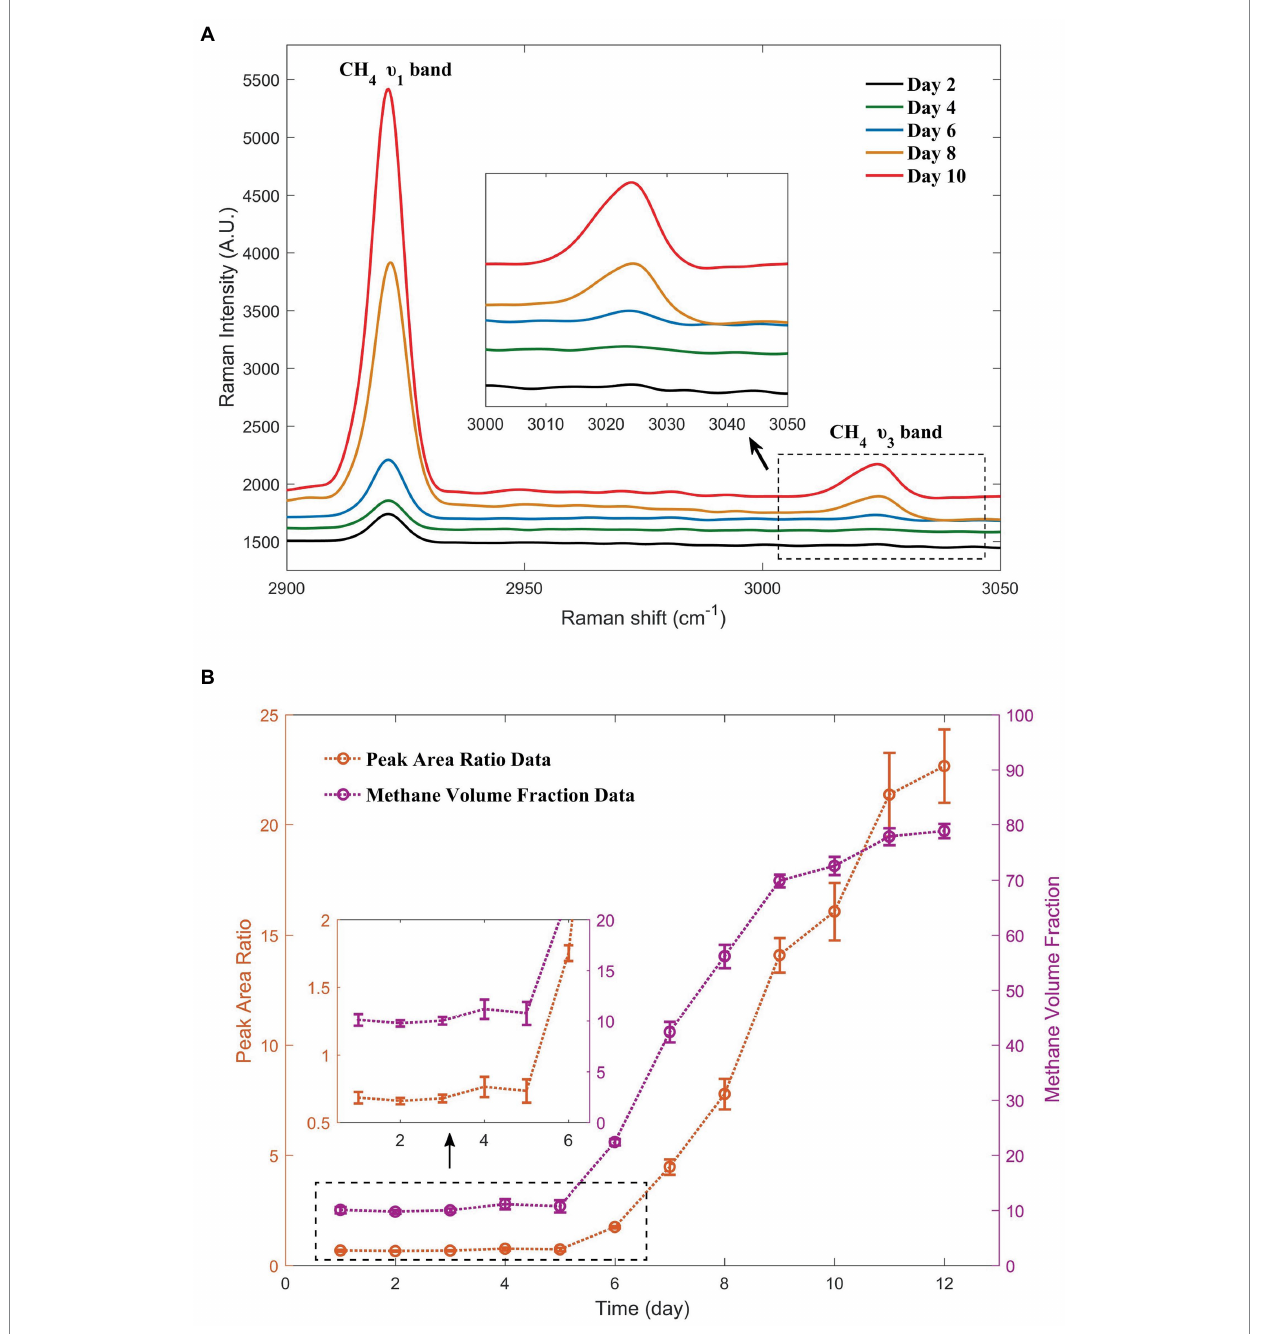
FIGURE 5 Changes in the methane peaks during the 5 days selected from the 12-day monitoring. The Raman spectra with simultaneous inclusion of nitrogen peaks were shown in Supplementary Figure S1 (A) . Methane production, as demonstrated by the methane peak area ratio with nitrogen and methane volume fractions calculated from the curve over a period of 12 days (B)